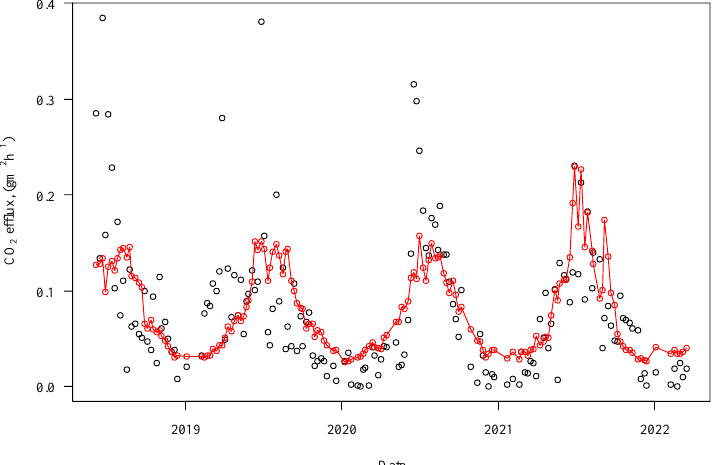
Figure 5. Outputs of the exponential model for the CO 2 efflux (g m − 2 h − 1 ) from undisturbed bare soil within the period of 2018 – 2022. Measured and calculated data are represented by black and red circles, respectively.